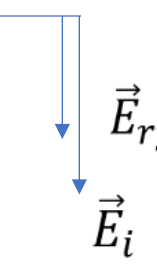
Figure 3. Components of the incident and reradiated electric